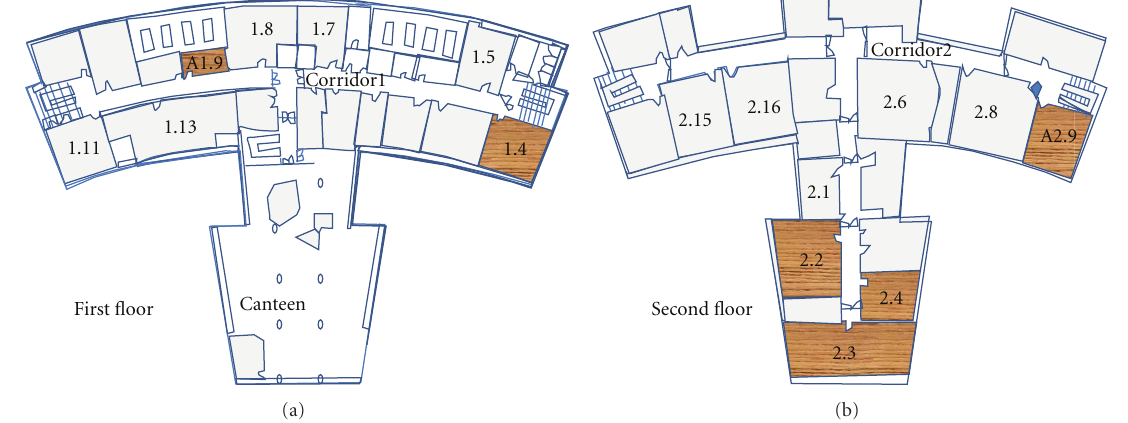
Figure 1: Plan of (a) first floor and (b) second floor of Anglesea Building showing measurement locations.